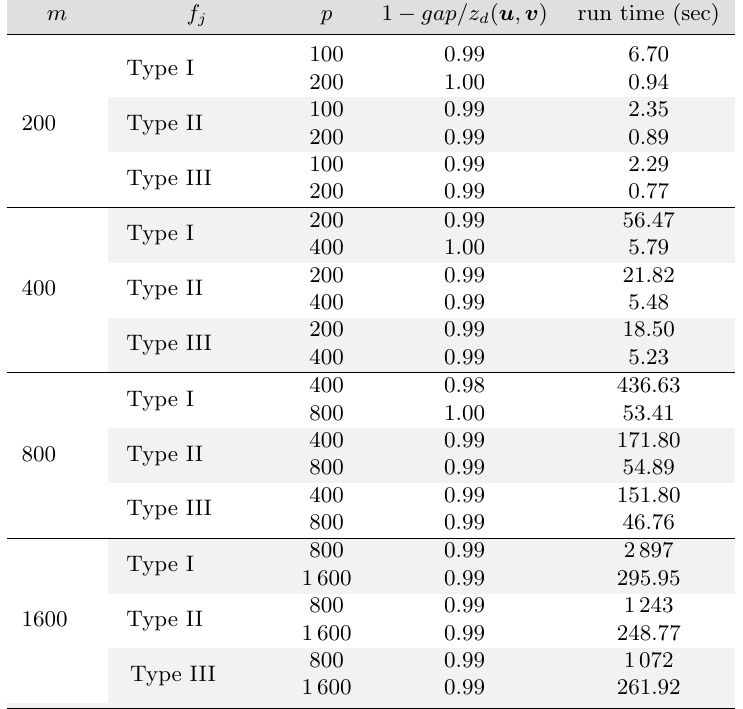
Table 1: Algorithm performance and run